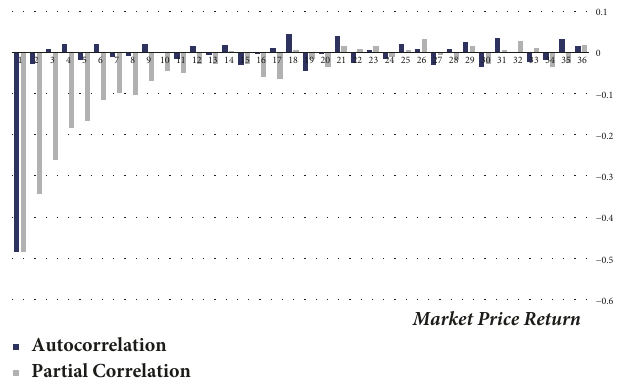
Figure 4: Varying process of the autocorrelation and partial correlation related to the market return